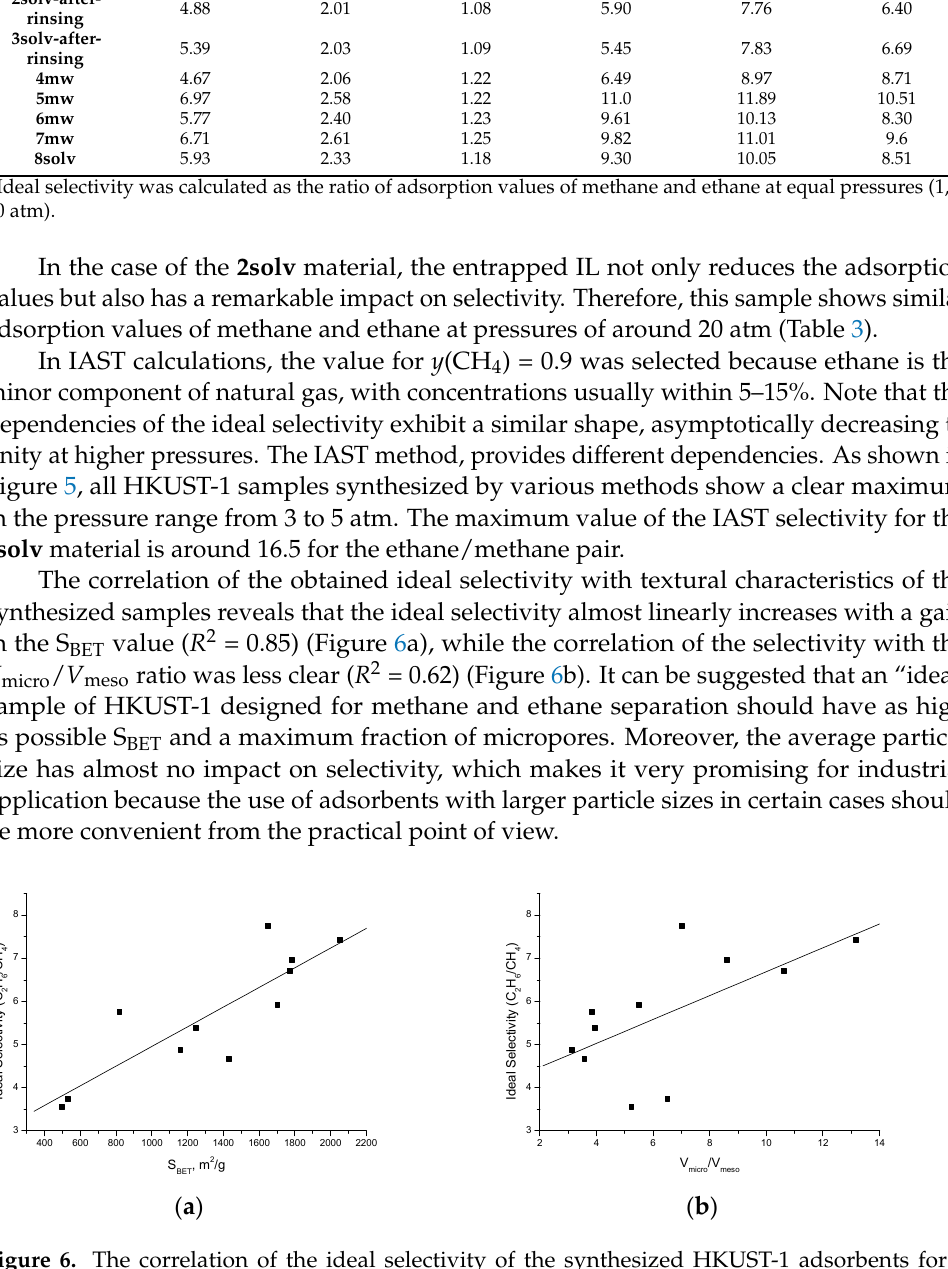
Figure 6. The correlation of the ideal selectivity of the synthesized HKUST-1 adsorbents for a C 2 H 6 /CH 4 mixture with ( a ) S BET and ( b ) V micro / V meso .